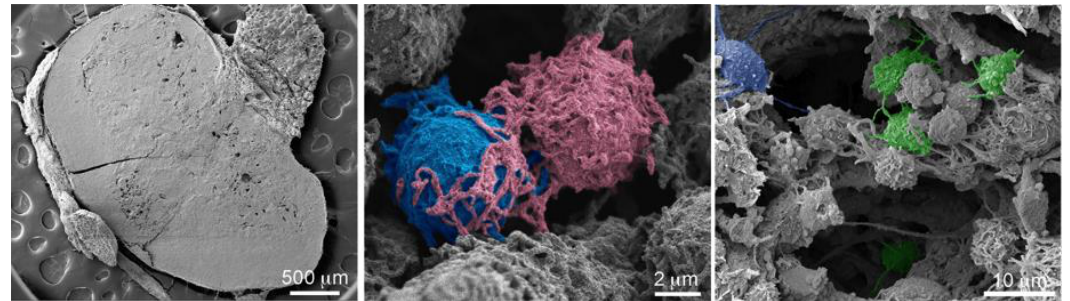
Figure 9. In vivo cellular interactions. Scanning electron micrographs show a sectioned inguinal lymph node ( left ) and higher magnification images of cells within the lymph node excised from a BALB/c mouse with a 4T1 breast tumor. Several cells are pseudo-colored to distinguish the cells and highlight extensive cellular connections between cells in close proximity ( middle ) or at a distance ( right ).